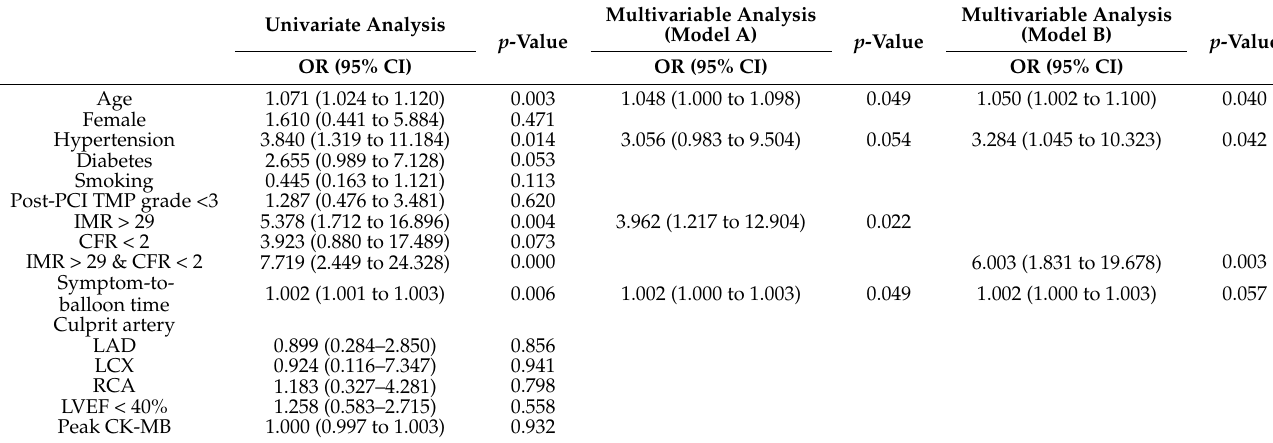
Table 5. Logistic regression analysis for independent predictors of death or hospitalization for HF.